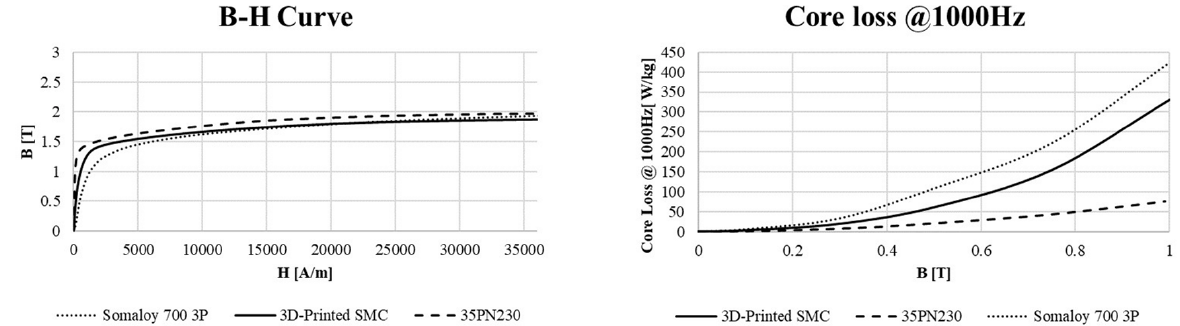
Figure 2. Comparison B-H Curve and Coreloss data of existing SMC and 3D-printed SMC [16].